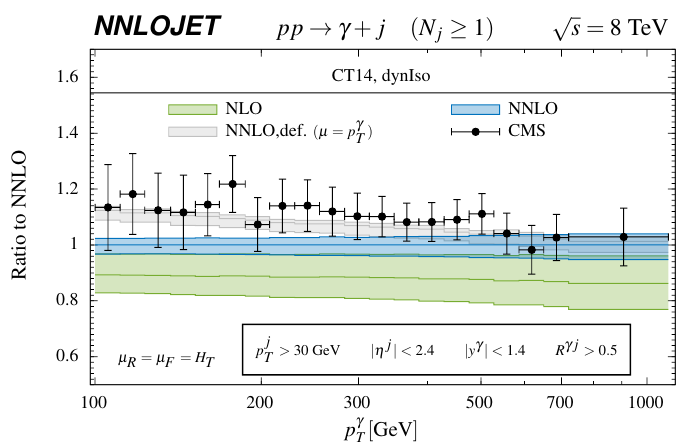
Figure 10 . Ratio to NNLO for the transverse energy/momentum of the photon at NLO and NNLO, using the PDF and isolation procedure choice of MCFM [39]. The default NNLO result is shown in